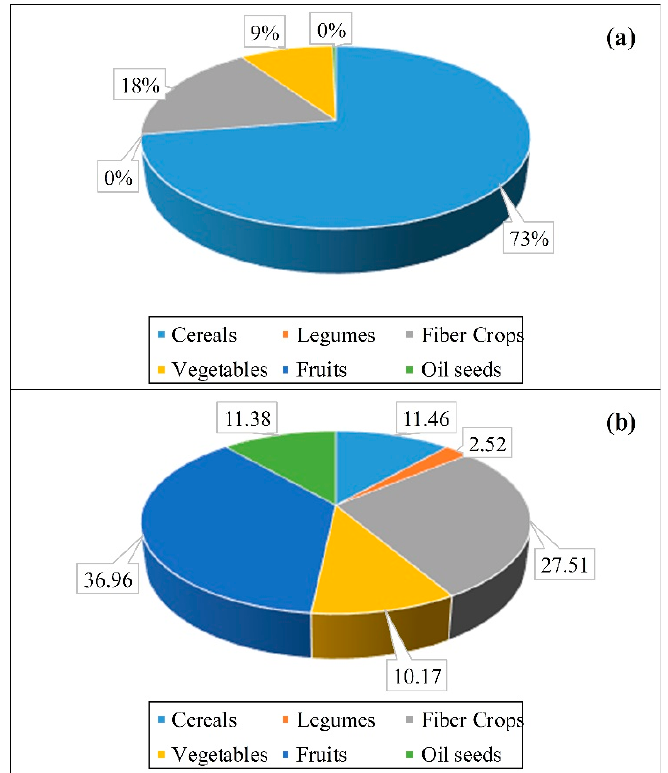
Figure 4. (a) The state of cultivation area, and (b) the crop production in each county.